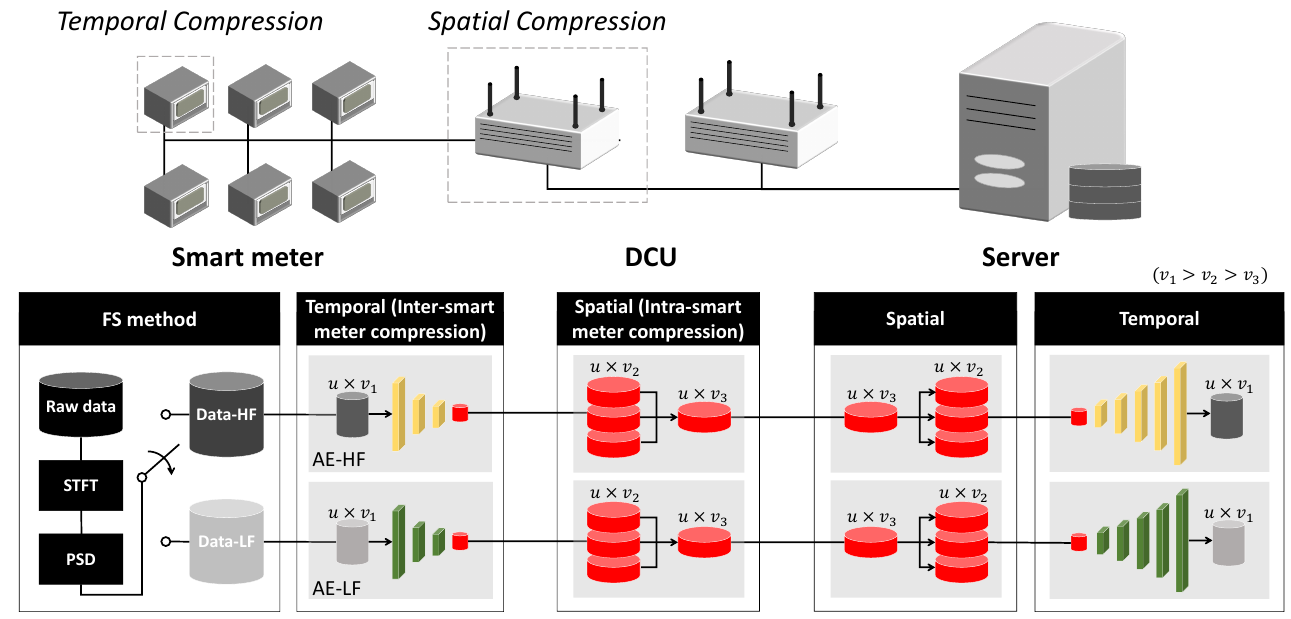
Figure 2. Overall diagram of the proposed